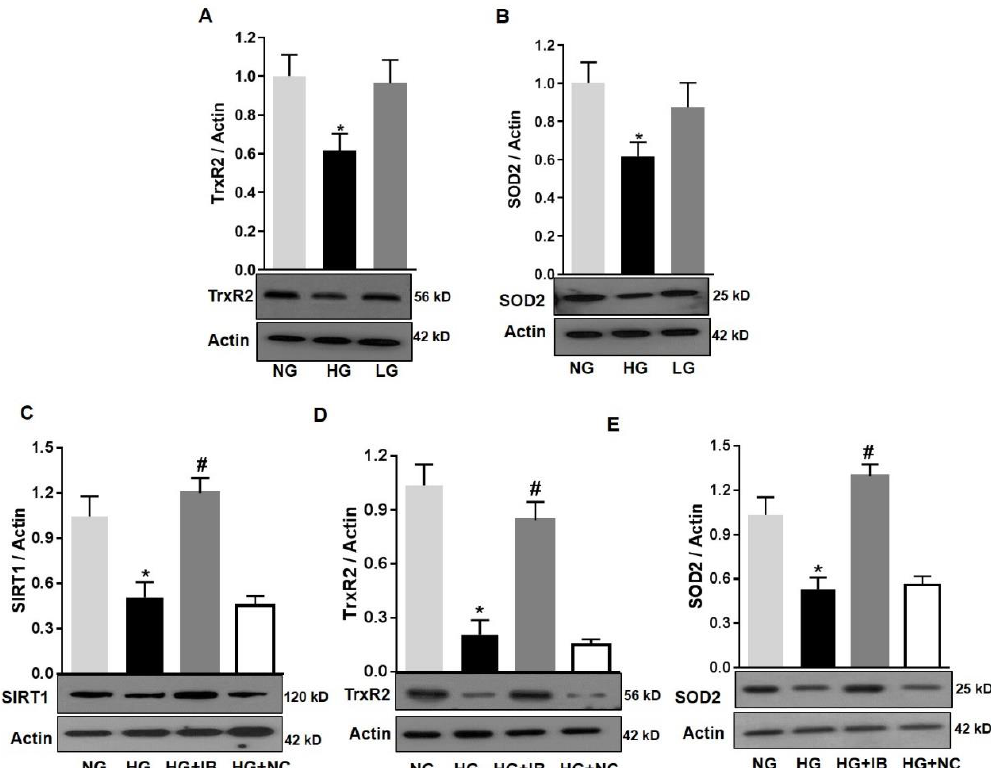
Figure 8. MiR-34a inhibition improves mitochondrial antioxidants in high-glucose-exposed HuREC. HuREC were treated for 48 h with high glucose (HG; 25 mM D -glucose, black bar) or normal glucose (NG; 5 mM D -glucose, light grey bar) or the osmotic control L -glucose (LG; 25 mM L -glucose, dark grey bar). Immunoblotting analysis showing the protein levels of ( A ) TrxR2 and ( B ) SOD2 in HuREC exposed to HG (black bar) and compared to NG (light grey bar) and LG (dark grey bar) controls. ( C – E ) HuREC were transfected with 50 nM of miR-34a inhibitor (miR-34a IB) or negative control (NC) for 24 h and exposed for 48 h with HG, NG, or LG. Immunoblotting analysis determining protein levels of ( C ) SIRT1, ( D ) TrxR2, and ( E ) SOD2 in HuREC treated with NG (light gray bar) or HG (black bar) alone or followed by transfection with miR-34a IB (dark gray bar) and negative control (white bar). Changes in protein levels are expressed (bar histograms) as band density normalized versus actin. Bars represent mean value ± S.E.M; * p < 0.05 vs. NG and # p < 0.05 vs . HG, n = 4.